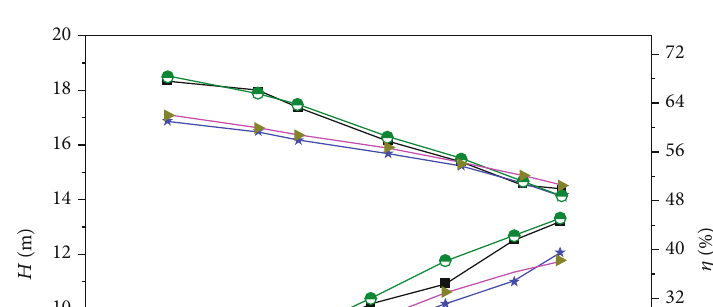
Figure 2: Mesh (Shi et al.